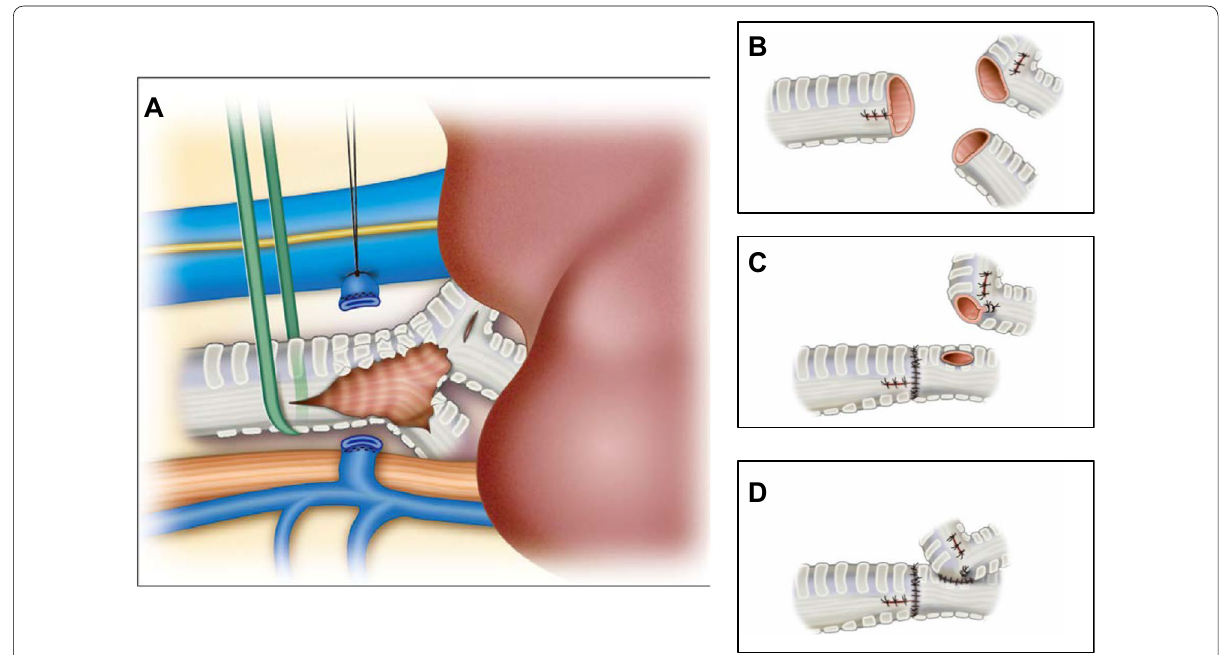
Fig. 2 Schematic overview. A Injured area of the tracheal bifurcation. B Resection of the injured area and suturing of the laceration area. C Anastomosis of the trachea and left main bronchus. D Anastomosis of the left and right main